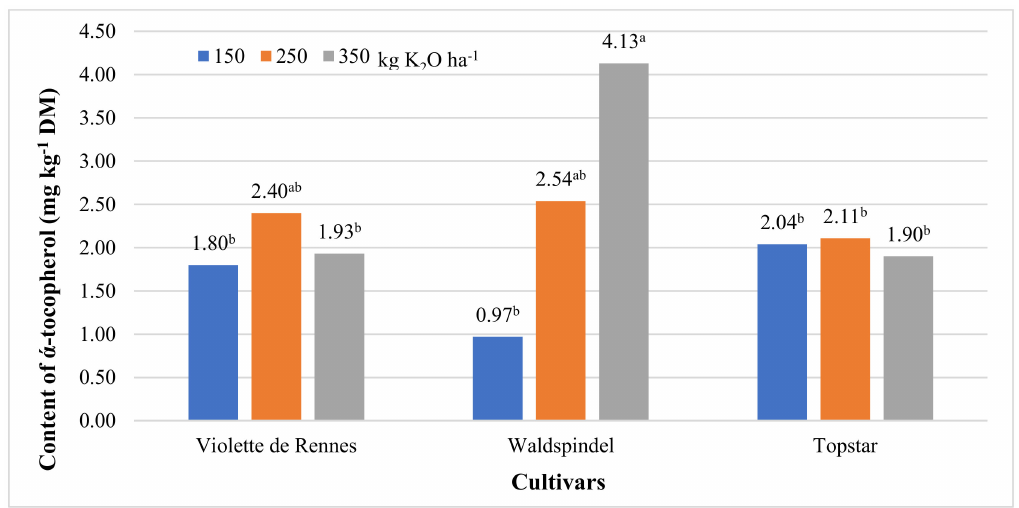
Figure 1. The e ff ect of potassium fertilization on the ´ α -tocopherol content of tubers in the analyzed Jerusalem artichoke cultivars. Means with the same letters do not di ff er significantly at p ≤ 0.05 in Tukey’s test. The absence of letters denotes non-significant main e ff